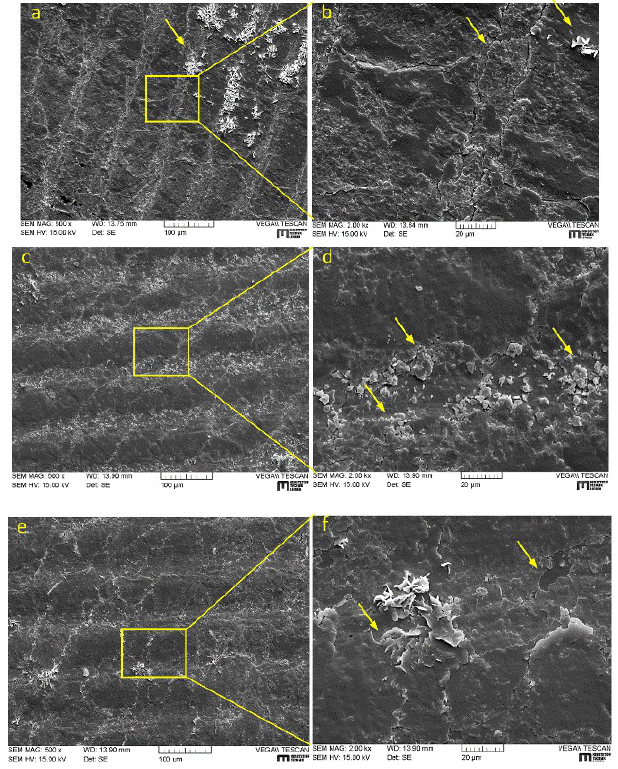
Figure 9. SEM micrographs: wear track of 300 nm DLC coated HNBR ( a ) and 300 nm Hybrid_A coated